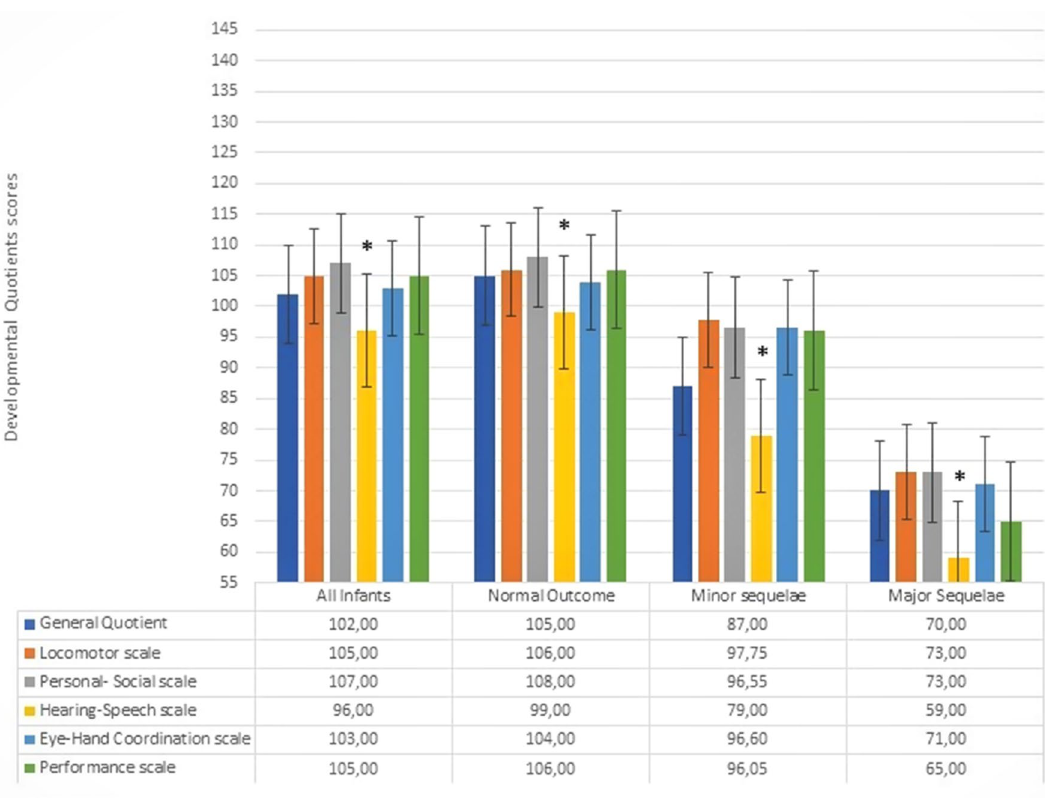
Figure 2. Developmental profile of the entire study sample and according to neurodevelopmental outcome categories at 24 months of CA. 95% CI. * = p < 0.001 among Hearing-Speech Scale and all other Scales in all groups of